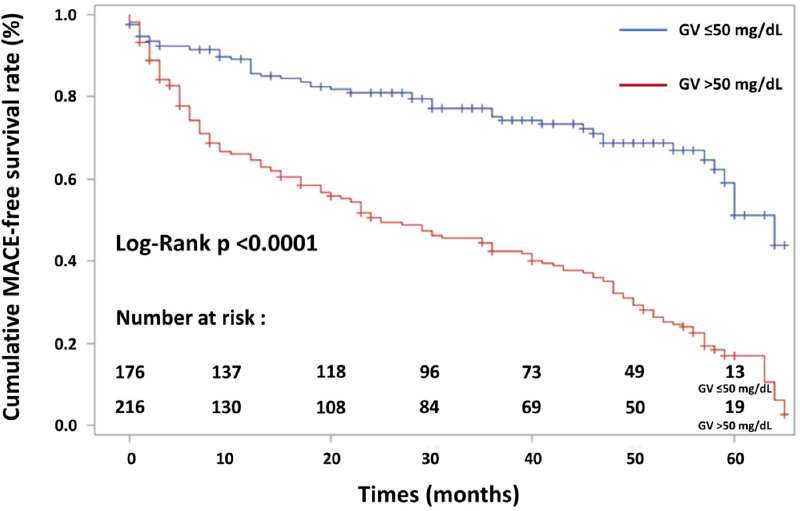
Figure 2. Kaplan–Meier event-free survival curves for freedom from MACE in two patient groups according to glycaemic variability (GV). Event-free survival rate was significantly lower in patients with high GV (log-rank test, p < 0.0001—solid blue line: GV ≤ 50 mg/dL; solid red line: GV > 50 mg/dL).